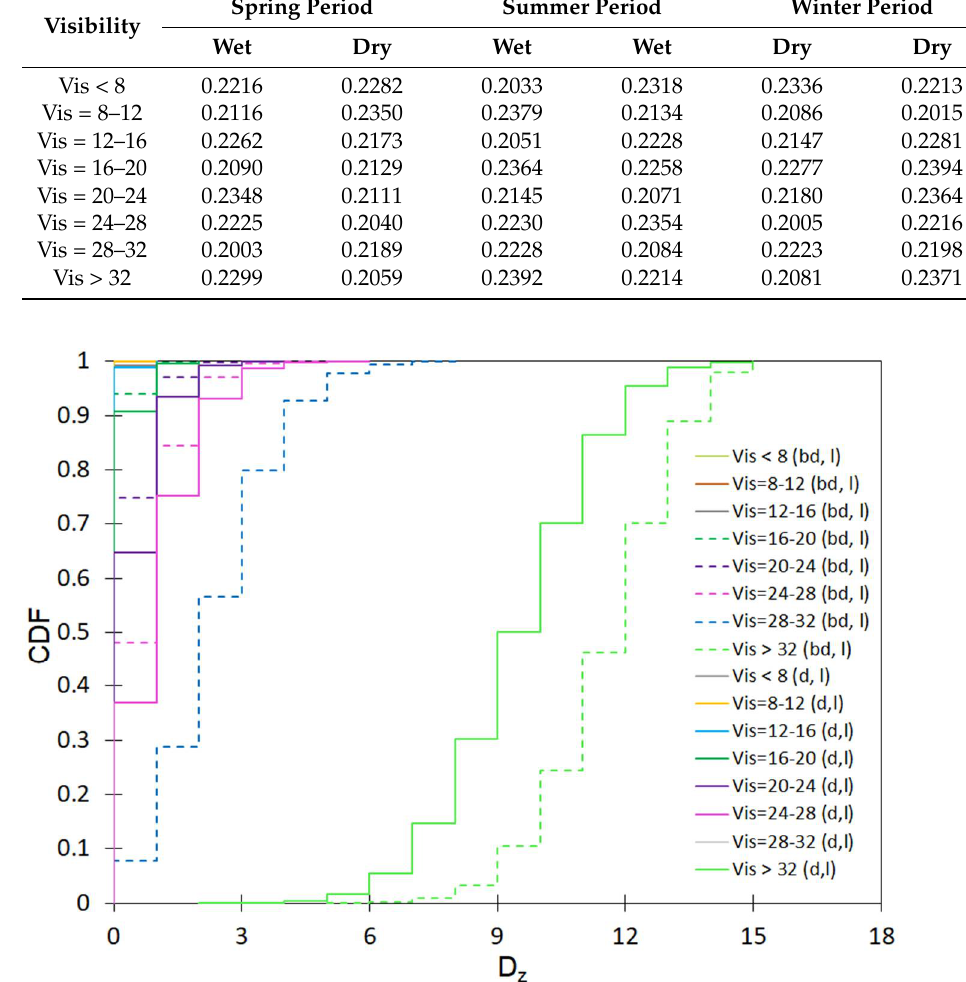
Figure A1. Number of days (D z ) with visibility in the respective range of variability for the precipitation and rainless period for summer.